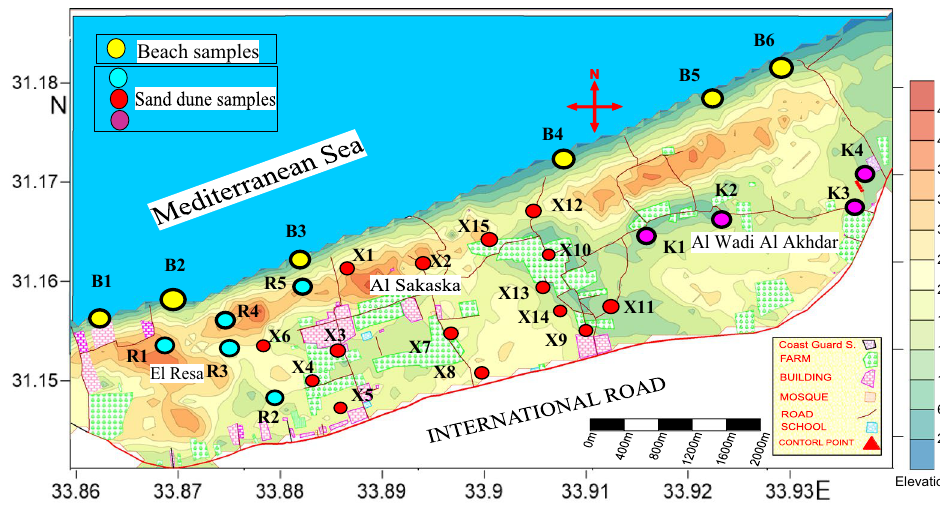
Figure 3. Topographic map shows samples location. Map was created by Surfer Software 13.6(2016) .https:// www. golde nsoft ware. com/ produ cts/